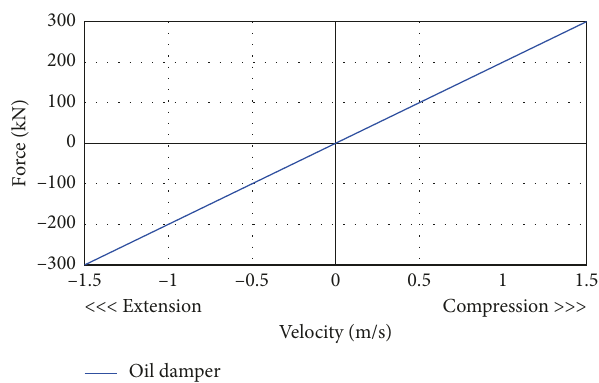
Figure 19: Oil damper